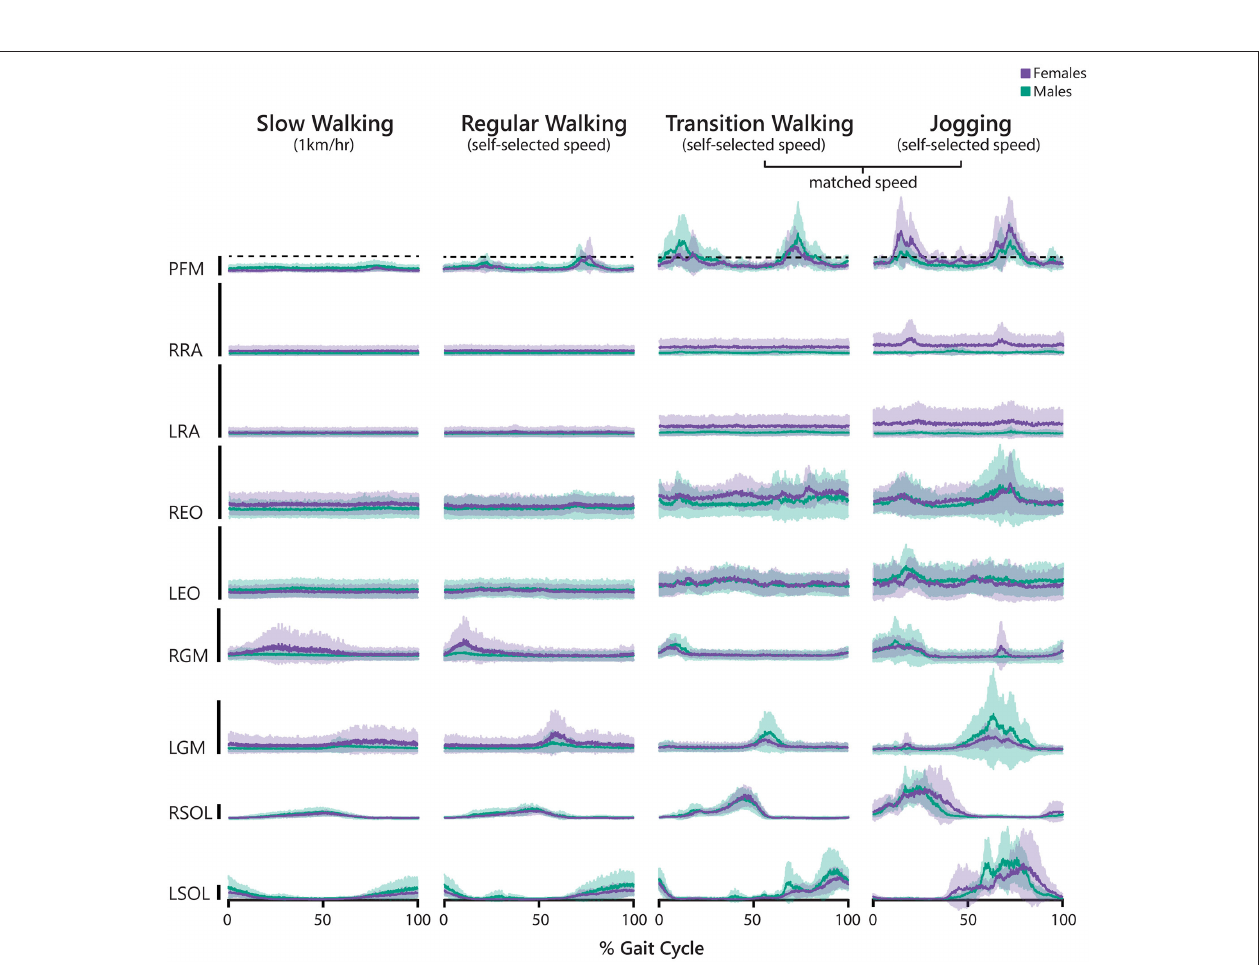
Frontiers in Human Neuroscience |